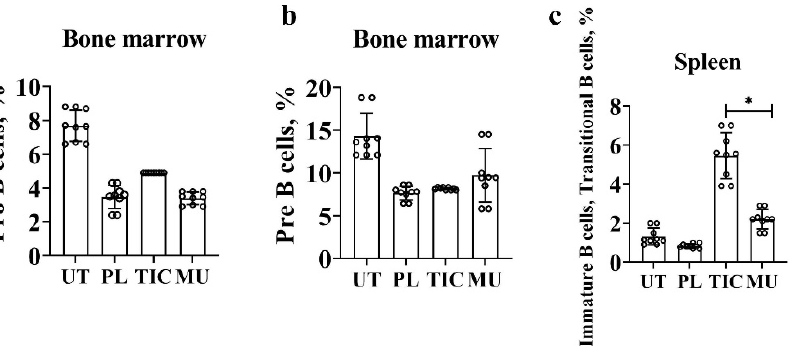
Figure 2. Results of flow cytometric phenotypic analysis. ( a ) The average level of pro-B cells (B220/CD45R + (APC)CD19 + (PerCP)CD43 + (PE)) in the bone marrow. ( b ) The average level of pre-B cells and immature B cells (B220/CD45R + (APC)CD19 + (PerCP)CD43 − (PE)) in the bone marrow. ( c ) The average level of immature B cells and transitional B cells (B220/CD45R+(APC)CD19 + (PerCP)CD43 − (PE)IgM + (FITS)) in the spleen. UT—untreated group, PL—placebo group, TIC—TIC group, MU—methyluracil group. The data are shown as mean value (M) ± standard deviation (SD) ( n = 6 mice/group). * One-way analysis of variance (ANOVA) was used to determine a statistically significant difference and the values were considered reliable at p < 0.05 and F > F crit .